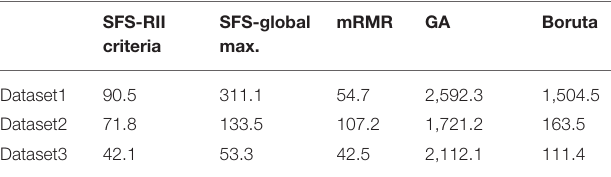
TABLE 4 | Running time for each FS method for each dataset